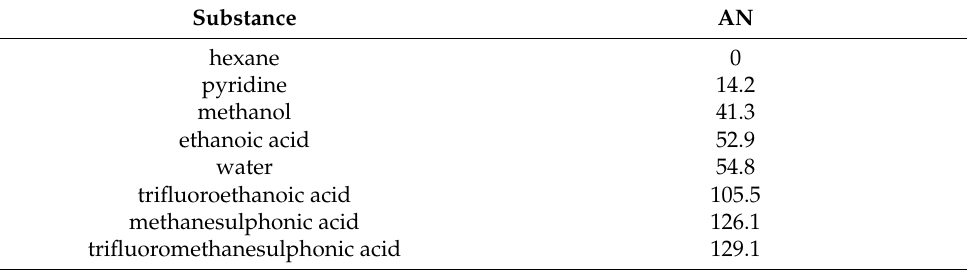
Table 1. Acceptor numbers of common substances [59].